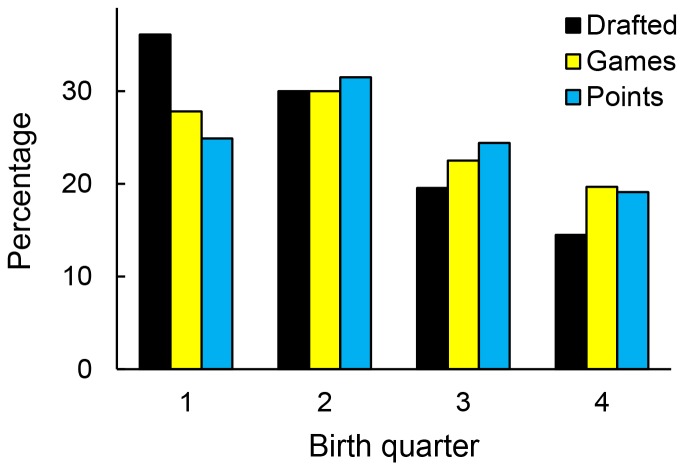
Percentage of draftees and productivity by relative age.